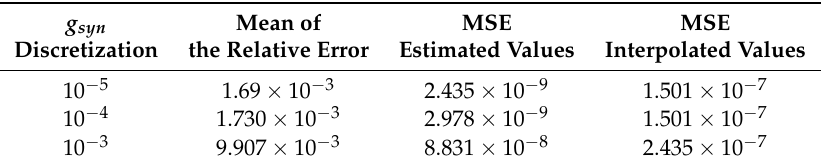
Table 2. Errors caused by the discretization used for the period–conductance relationship. This table shows the errors caused in the estimation when the deterministic pyramidal cell model is used both to generate the actual membrane potential and as a base model in the estimation procedure. The first column shows the discretization of the conductances used to build up the table that relates the period with constant values of the conductance in Algorithm 1, step 3b. The second column shows the mean of the relative error of the estimation. Third column shows the mean squared error obtained in each case. The last column shows again the mean squared error obtained after interpolating the estimated conductances using the PCHIP